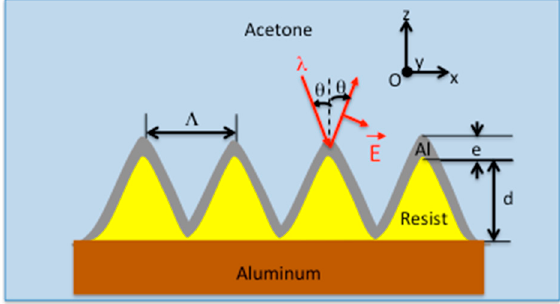
Figure 2. Parameters of the 1D structured sample for plasmonic effect in acetone with 𝑒 : Aluminum thickness, 𝑑 : Grating depth, Λ : Grating period, 𝜃 : Incidence angle, 𝜆 : Wavelength.